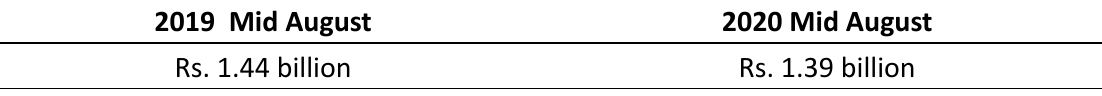
Table 3 : Shrink in Foreign Direct Invest ment after